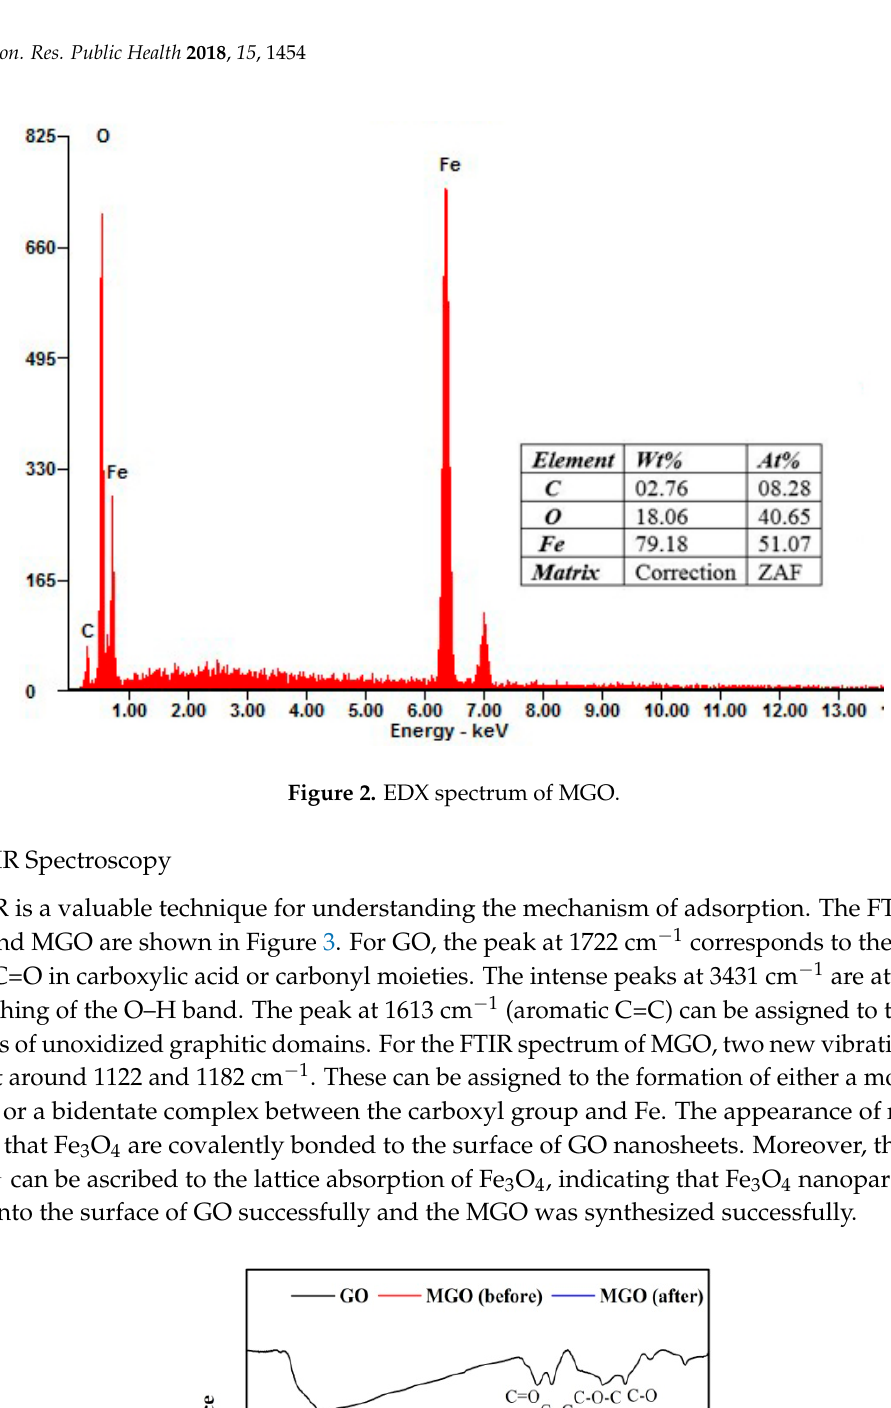
Figure 3. FTIR spectra of GO and MGO before and after the adsorption of estrogens.